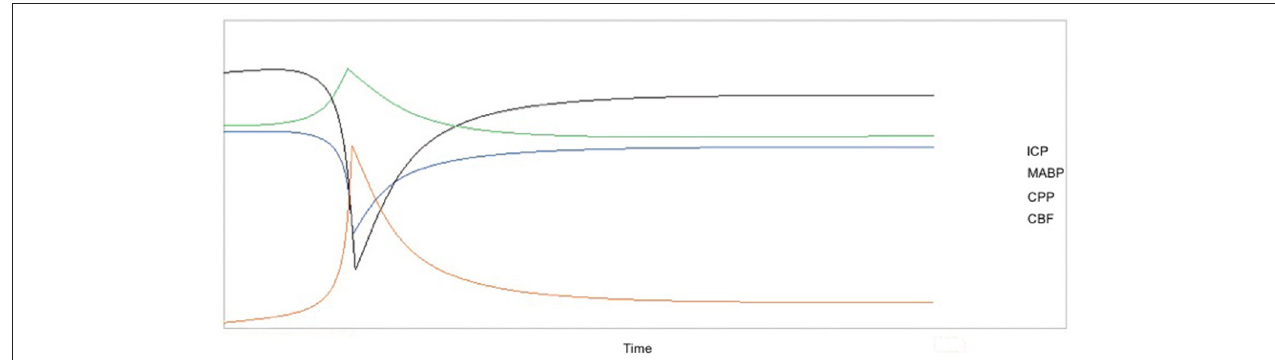
FIGURE 2 | Temporal changes in CBF, ICP, MABP, and CPP over 1h after induction of SAH with the x-axis representing the progression of time and the y-axis as relative change in each parameter. Due to the variation in the absolute values of these parameters after SAH (refer to Table 5 ), the relative changes in the variables are shown because these trends are preserved in nearly all preclinical studies and in humans. CBF and CPP sharply decrease shortly after SAH, followed by a return to near-baseline values within 1h. Similarly, there is an acute increase in both ICP and MABP, followed by a return to baseline or near-baseline values within 1h. Values for CBF were taken from studies that measured CBF using laser Doppler